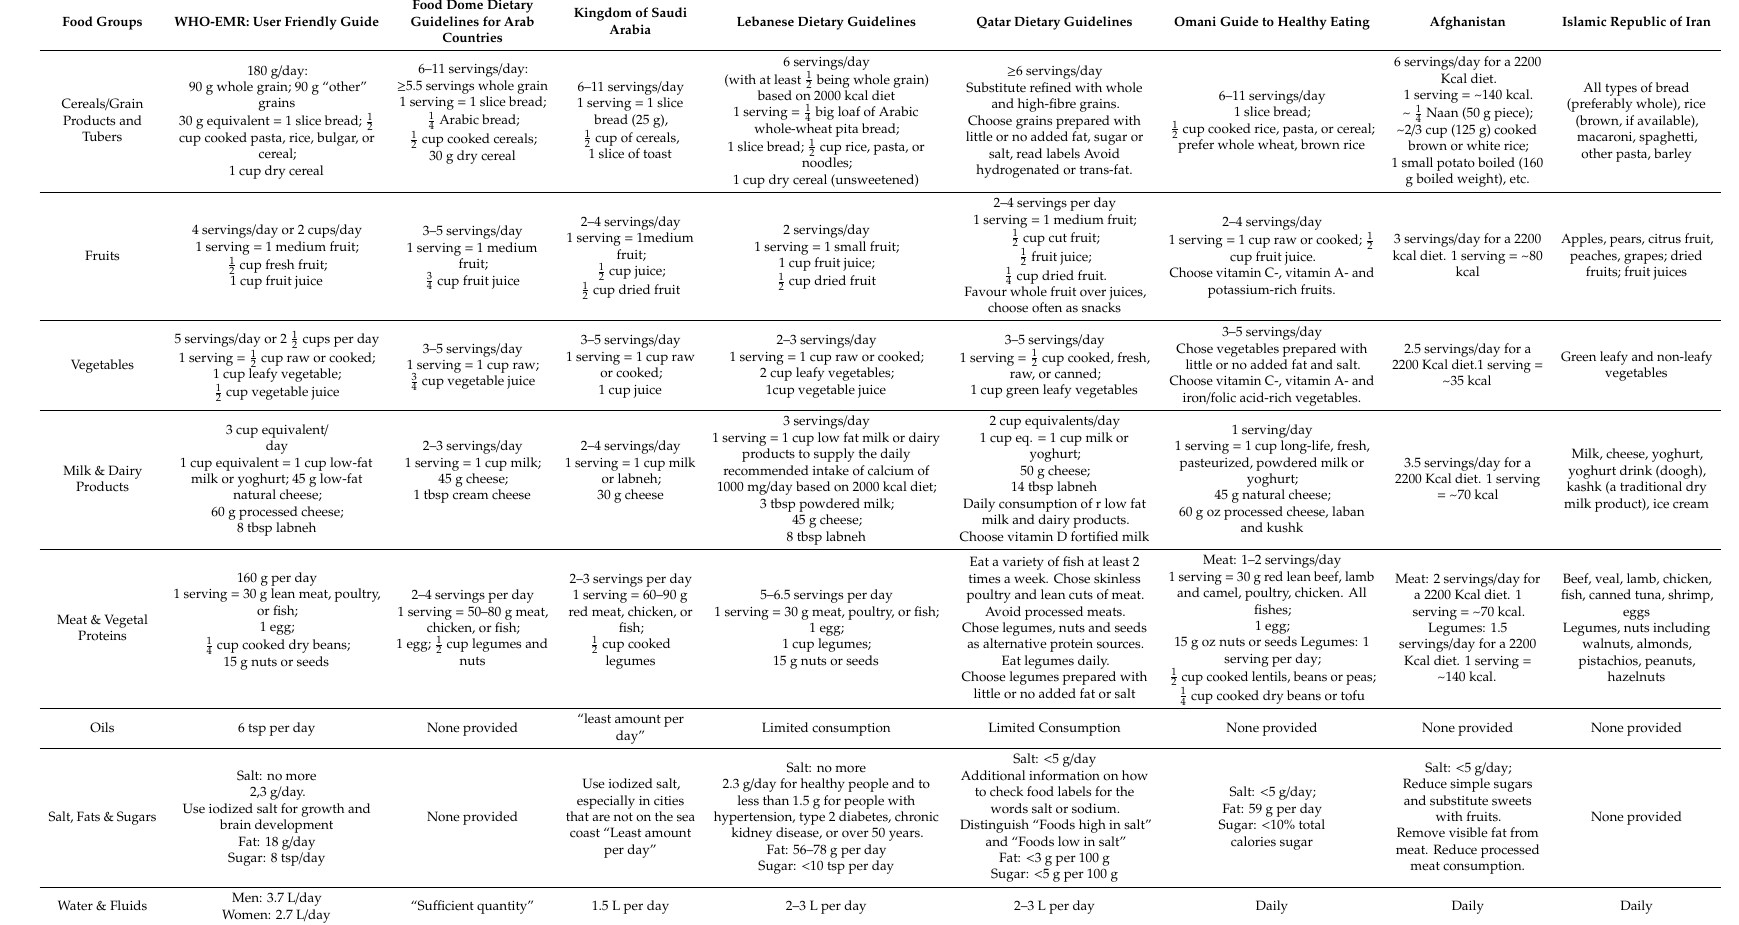
Table 2. EMR countries’ FBDGs dietary